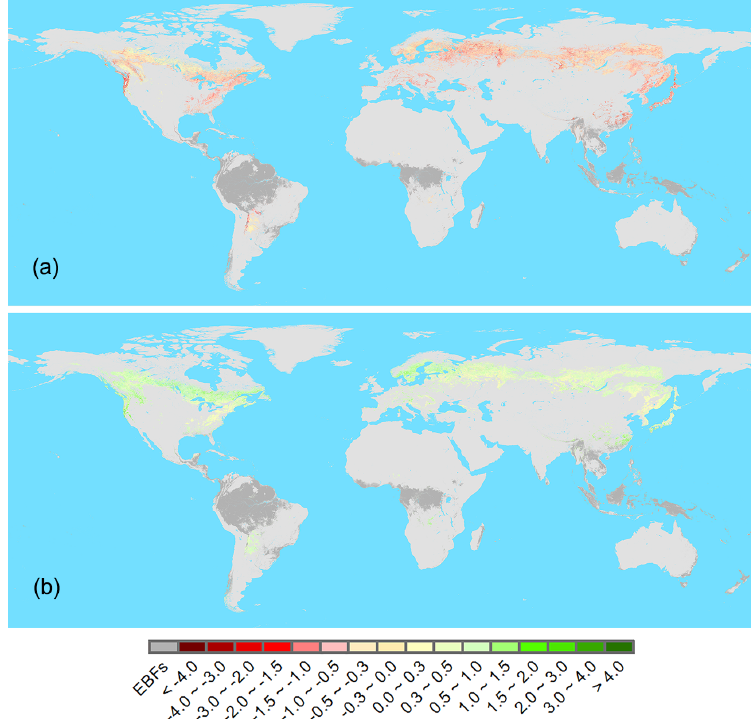
Figure 11. Maps of the differences (GLOBCARBON minus GLOBMAP) between (a) the GLOBCARBON LAI and the GLOBMAP forest total LAI (sum of the overstory and understory LAI) and (b) the GLOBCARBON LAI and the GLOBMAP forest overstory LAI. The results for the EBFs are